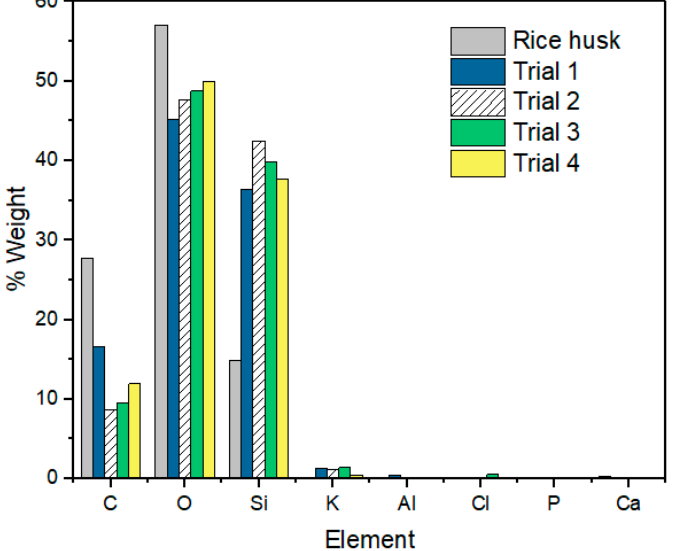
Figure 8. Elemental analysis of the produced